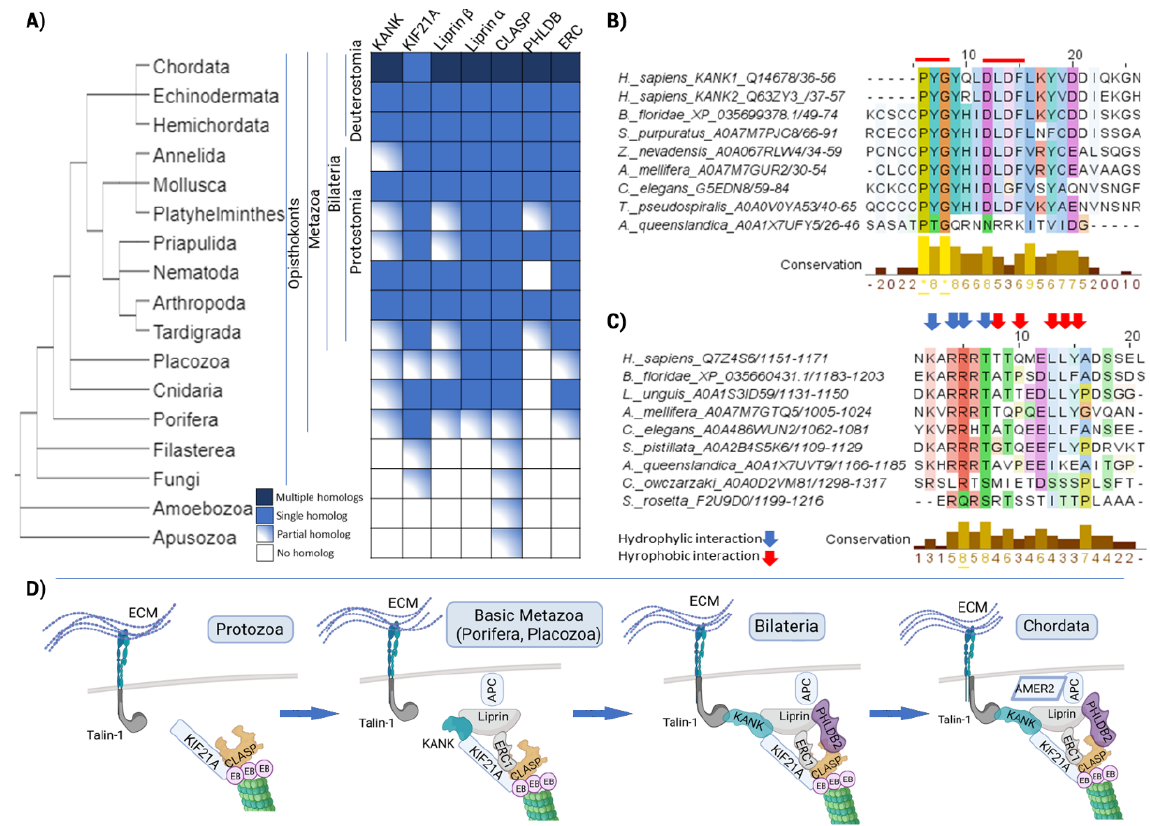
Figure 6. Analysis of the evolutionary origins of CMSC complexes as microtubule-focal adhesion linkers. ( A ) Presence of cortical microtubule stabilisation complex (CMSC) component homologs in different Amorphea groups. The search for homologs was performed as described in M&M, hits obtained after initial BLAST search to human queries were reciprocally BLAST to verify the best hits. A protein was marked as a partial homolog if the coverage was <40% compared to the human protein, while in the case of KIF21A and KANK, conservation of known interaction motifs with KANK and talin was used, respectively. ( B ) Conservation of KN motif in KANK (talin-binding), residues involved in specific interactions with talin are marked with red line. ( C ) Conservation of KBD (KANK-binding domain) in KIF21A, residues involved in specific interactions with KANK are marked with red/blue arrows. ( B , C ) 0 → * increasing amino acid (aa) residues conservation, * = aa residues in all sequences are conserved. ( D ) Increase in complexity of CMSC components from unicellular opisthokonts to Chordata. Although CMSC originate in the premetazoa, they gradually acquire new components during animal evolution.